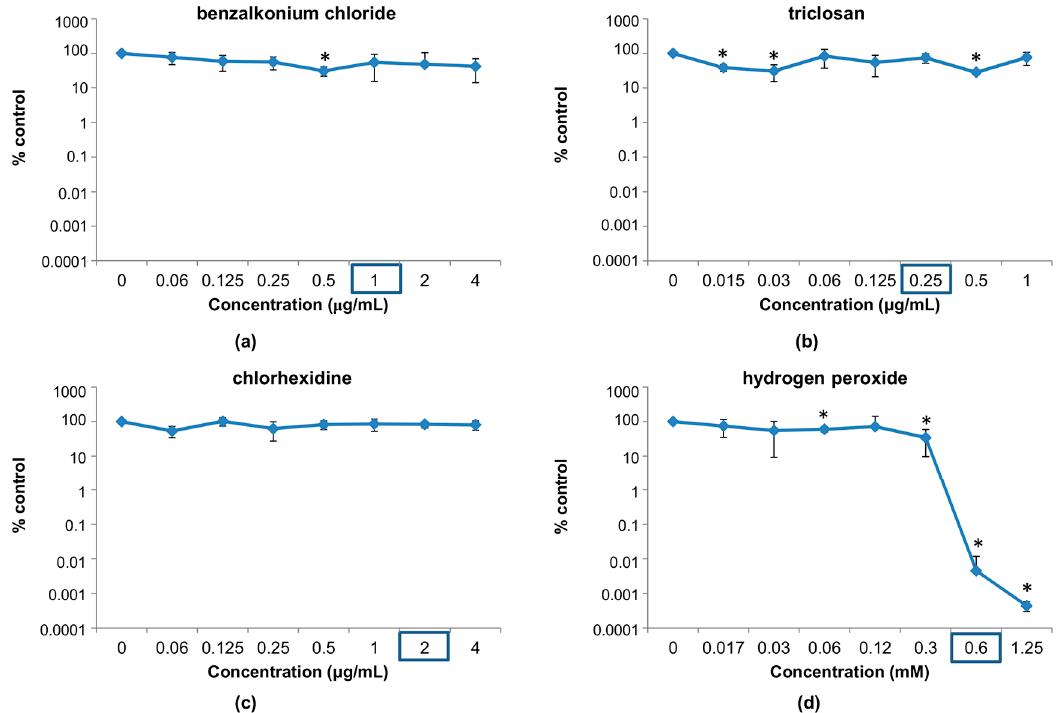
Figure 1. Percentage of survival of phiIPLA-RODI phage particles after overnight treatment with different concentrations of disinfectants: ( a ) benzalkonium chloride; ( b ) triclosan; ( c ) chlorhexidine; ( d ) hydrogen peroxide compared to an untreated control without disinfectant. The minimal inhibitory concentrations (MIC) for S. aureus IPLA1 for each disinfectant is marked with a blue rectangle. * p - Value < 0.05.